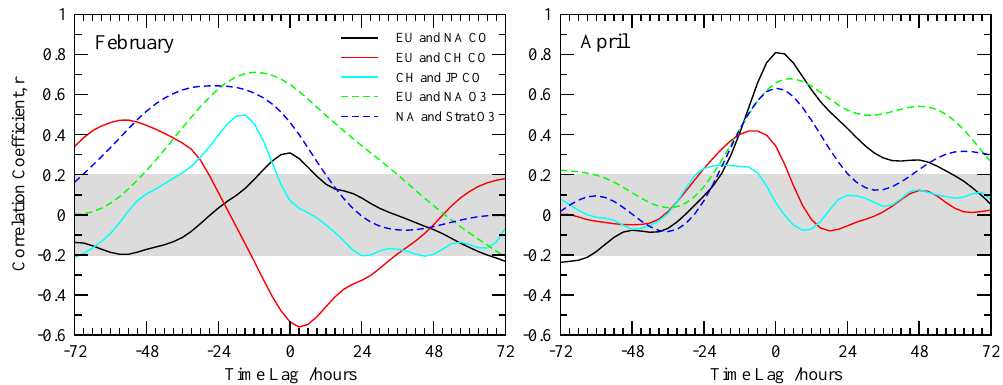
Fig. 10. Correlation between the contributions of key source regions to O 3 and CO over Tokyo in February (left) and April (right).